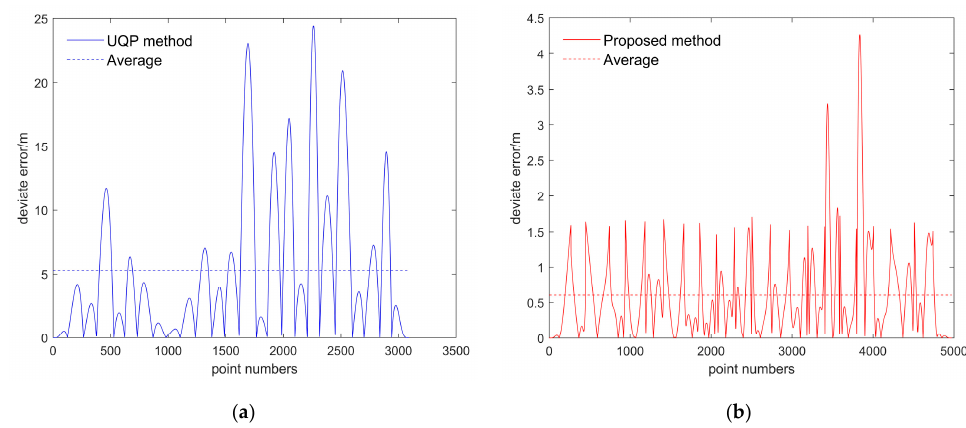
Figure 8. Deviation distance between each pair of points: ( a ) the deviate error distance of the unconstrained quadratic programming (UQP) method; ( b ) the deviate error distance of the proposed method.